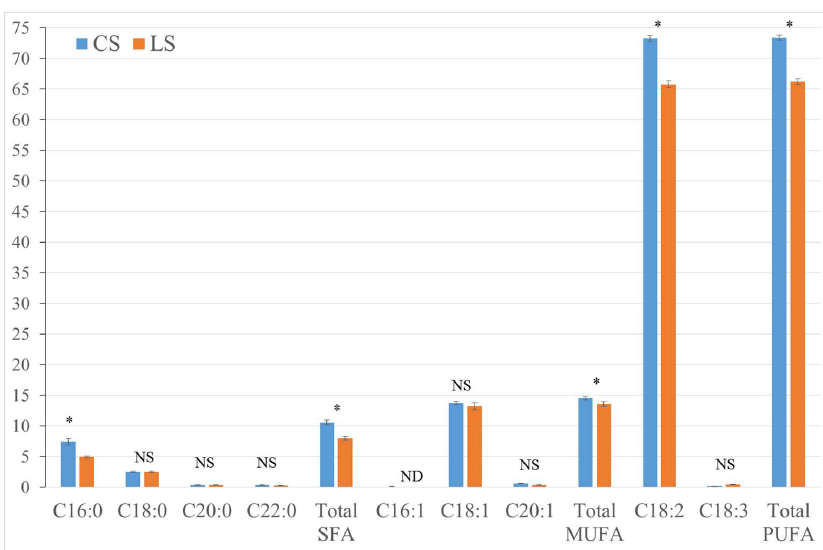
Figure 3. Fatty acid composition of safflower seeds cultivated under conventional ( CS ) and late sowing dates ( LS ) in Auch (South West of France) in 2007. The asterisk indicates that means are significantly different. ND: Non-determined. NS: Non-significant.